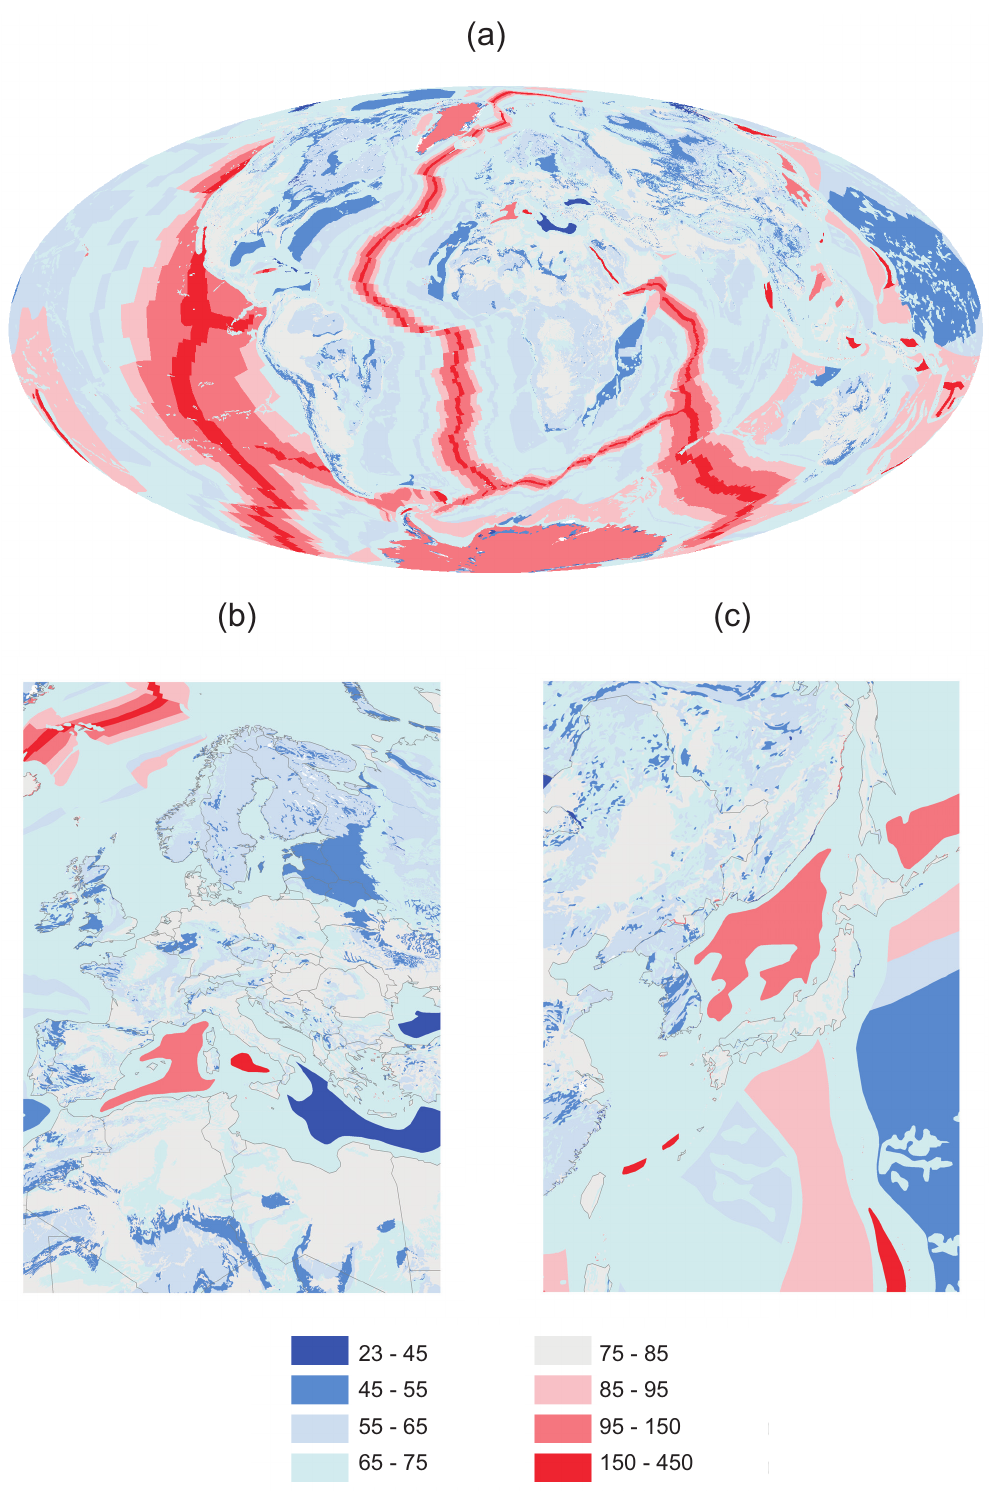
Fig. 10. (a) Map of the preferred global heat flux (mWm − 2 ) , utilising the underlying estimates for each geology category. Note that in regions with no data (see Fig. 1) the estimate is based solely on the assumed correlation between geology and heat flux. As a result, locally, the values presented could provide a poor estimate. Estimates in better-covered areas of the globe, however, suggest that on average, the current estimates are robust; higher resolution plots, focussing upon Europe (b) and Japan (c) are also shown.